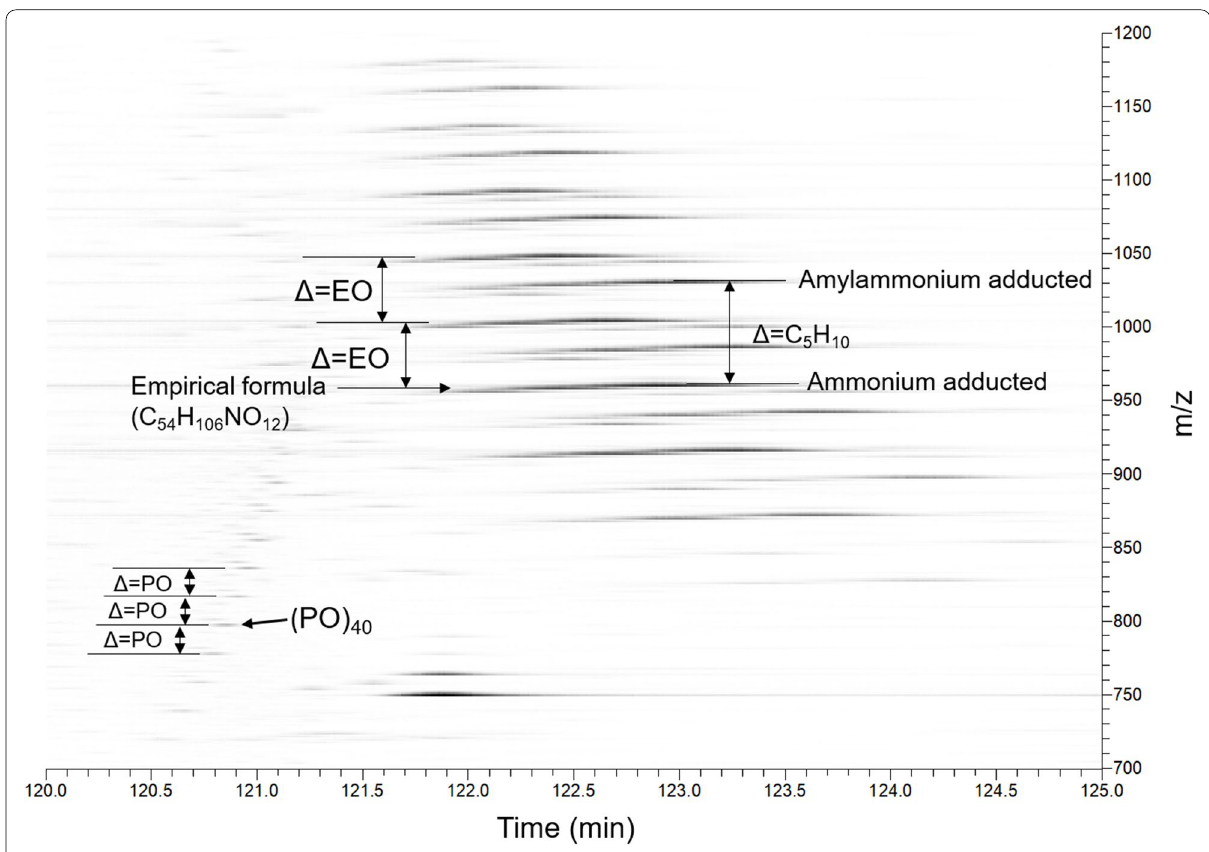
Fig. 9 The mass map overview of elution from RT 120 to 125